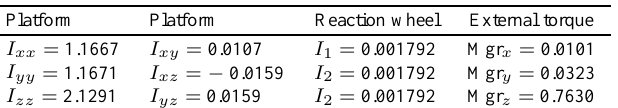
Table 2 Parameters estimation and